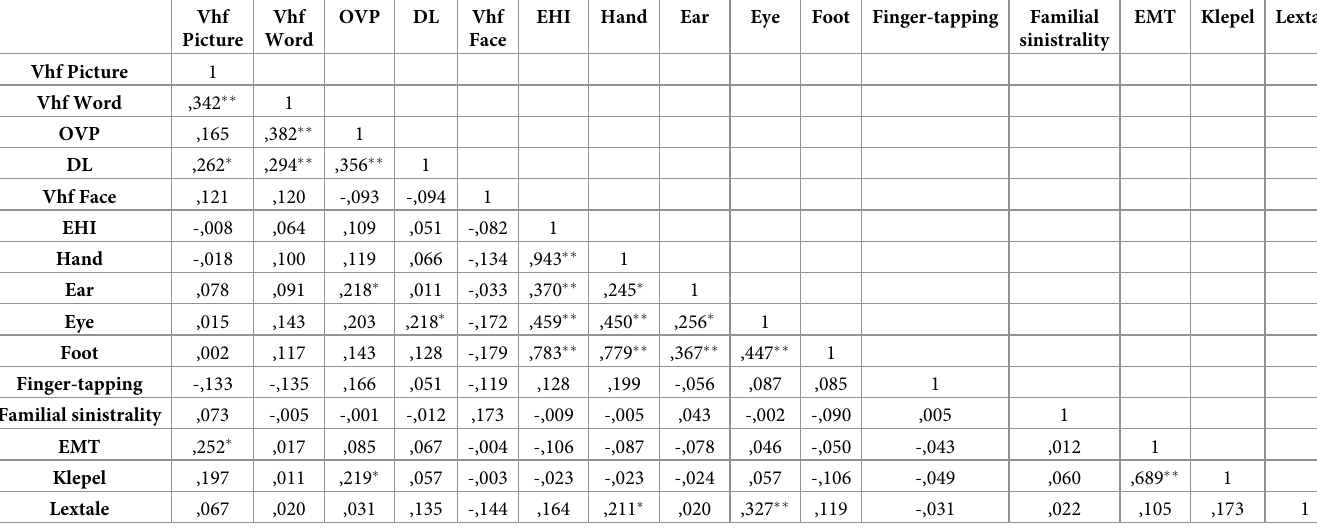
Table 2. Pearson correlations between all variables tested, with the lateralization indices based on reaction times for the visual half field tasks and left/right ear matches for the dichotic listening task.